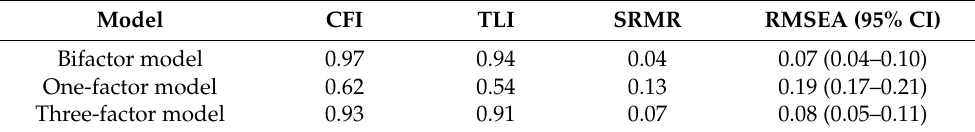
Table 2. Confirmatory factor analysis ( N = 141).